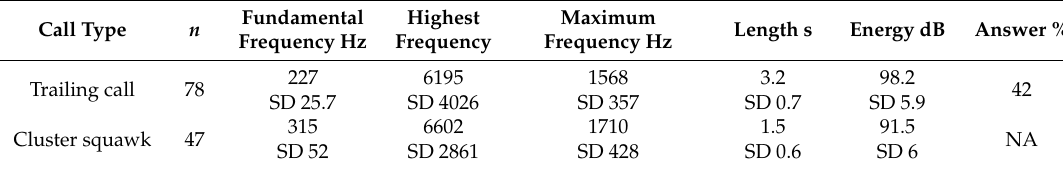
Figure 8. Comparison of Otolemur cluster squawk and trailing calls. The dots indicate maximum frequencies. The trailing call is clearly longer (average 3.2 s) than the cluster squawk (average 1.7 s). Table 3. Vocal characteristics of Taita Hills Otolemur